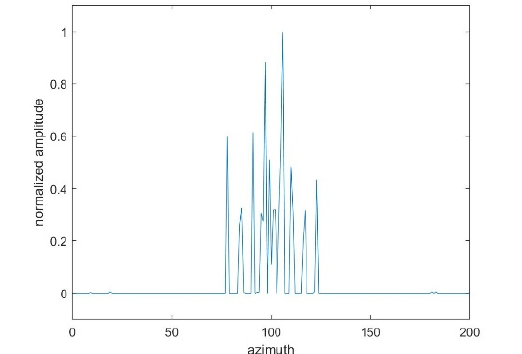
M M 58 8 . It d a